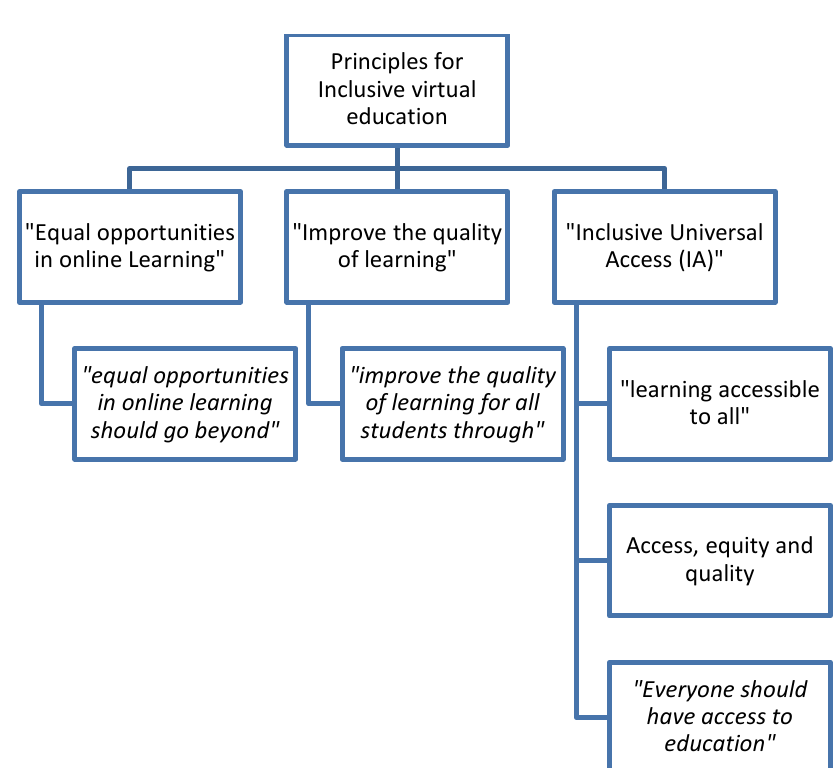
Figure 9 . Principles for inclusive virtual education. This mind map illustrates the property and its dimensions. The dimensions give off codes, with some of them framed in quotation marks and italics. This is because they are "in vivo" codes and/or quotations from some of the articles studied, while the others are codes created by the